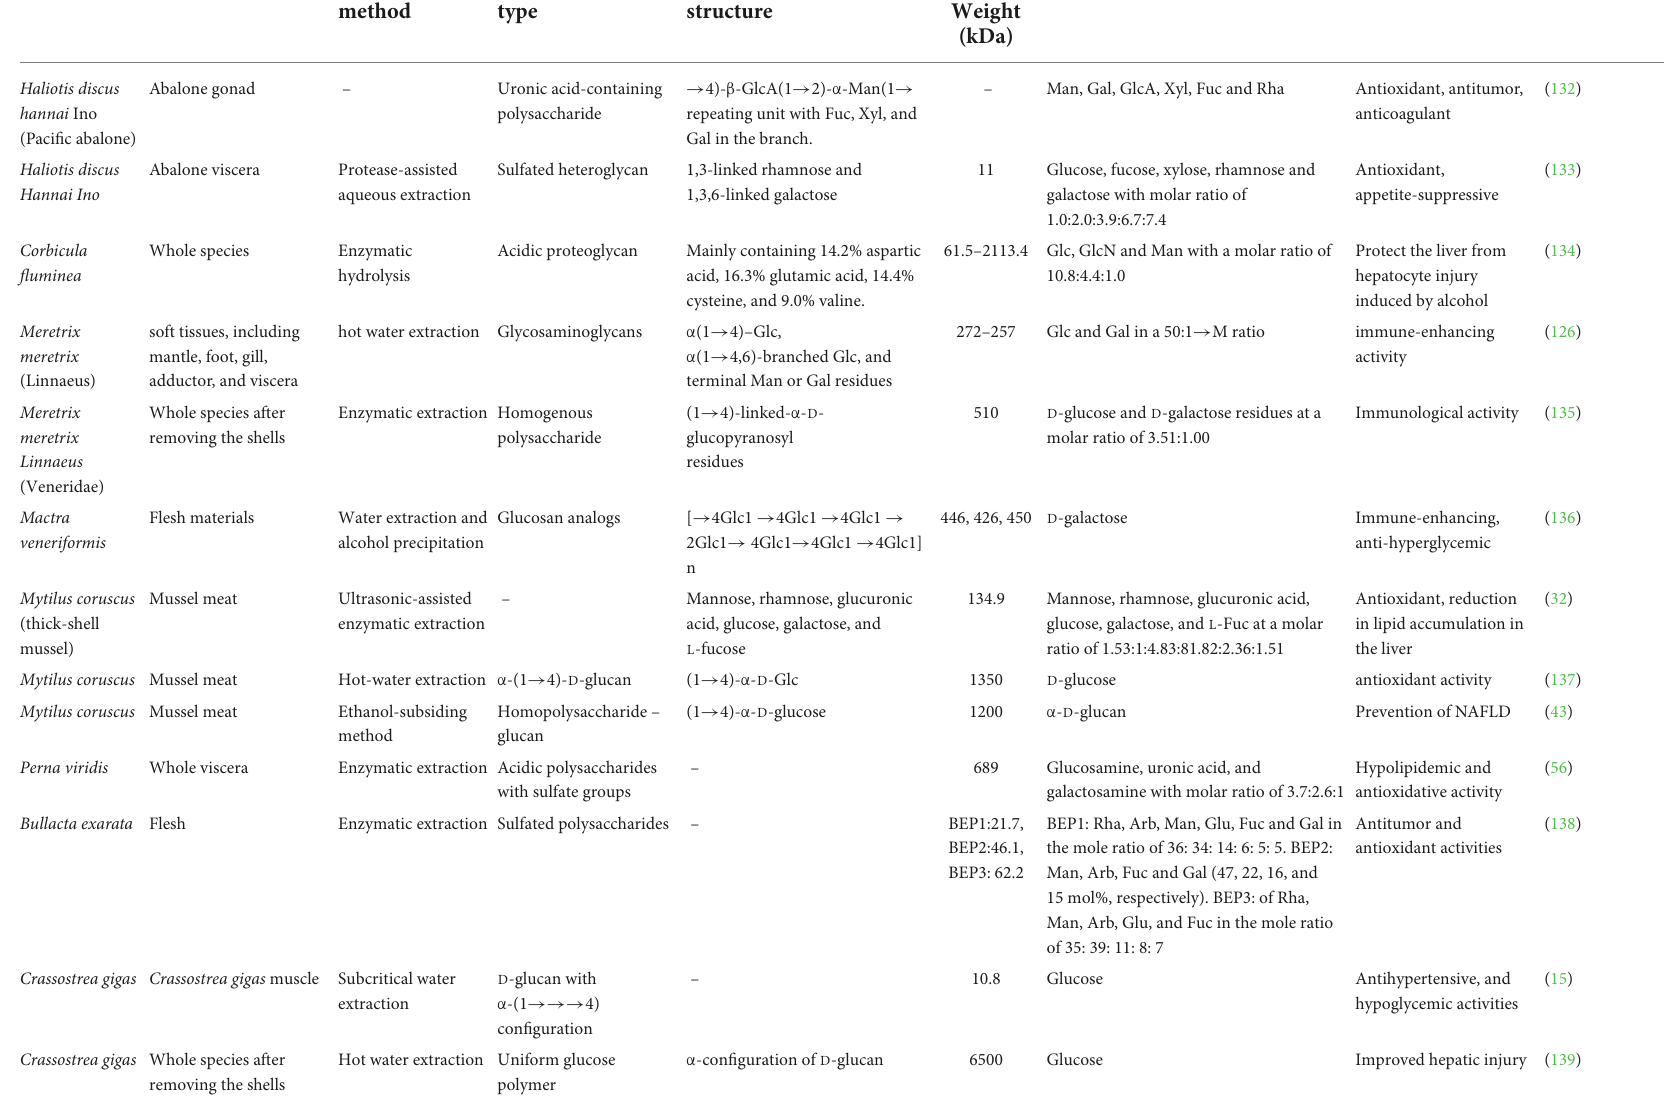
TABLE 3 Structural analysis and biological activities of shellfish